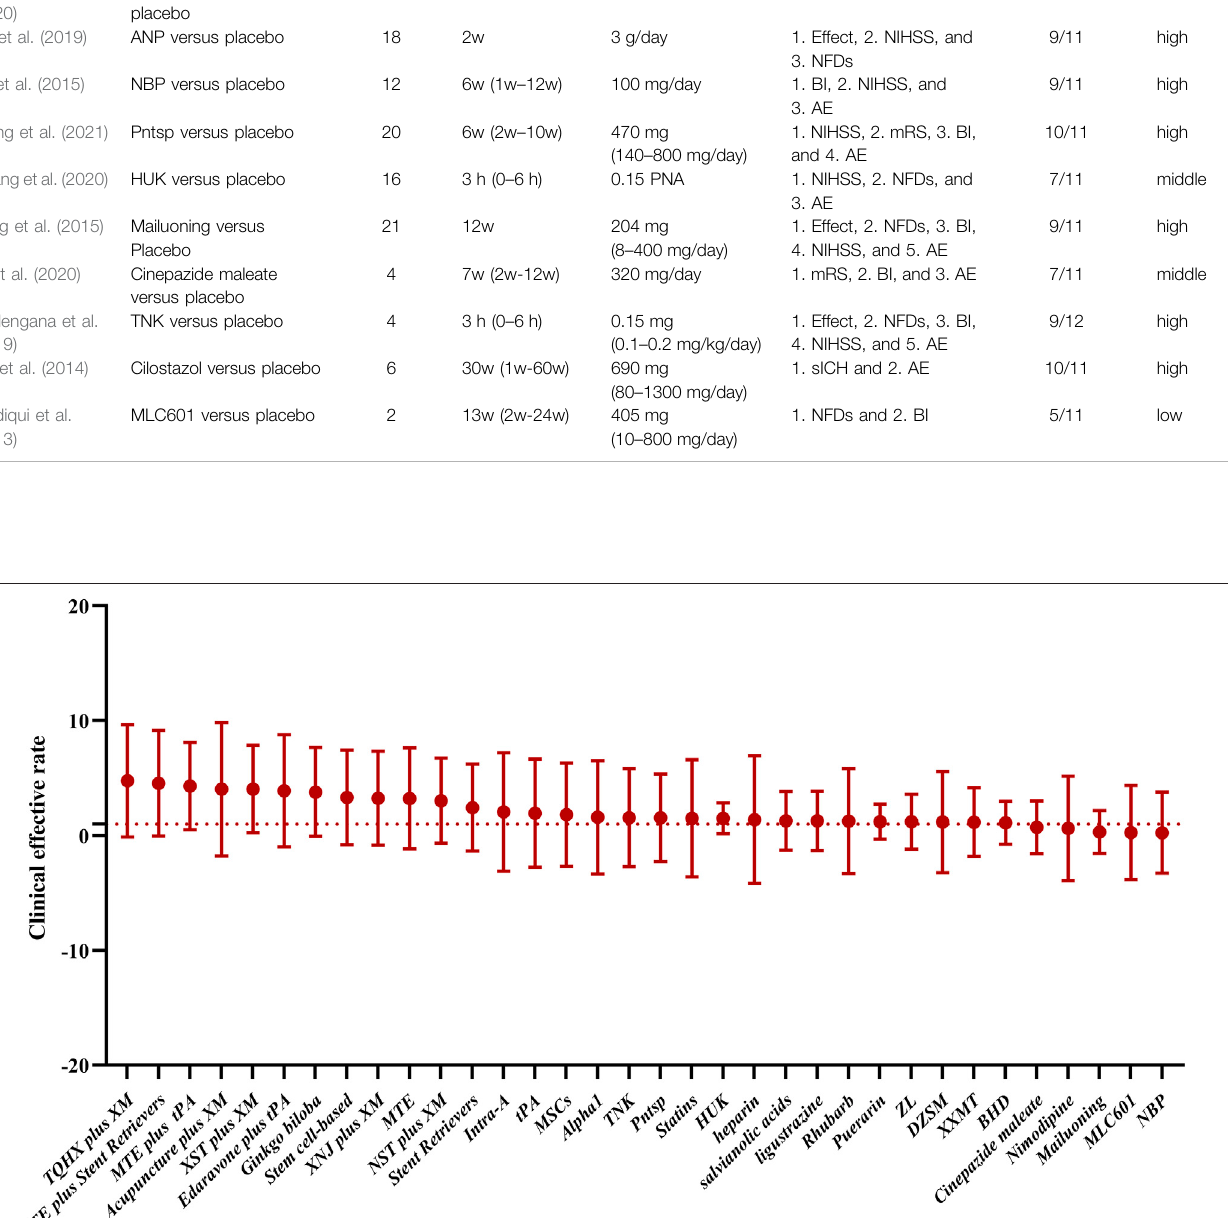
Frontiers in Pharmacology |